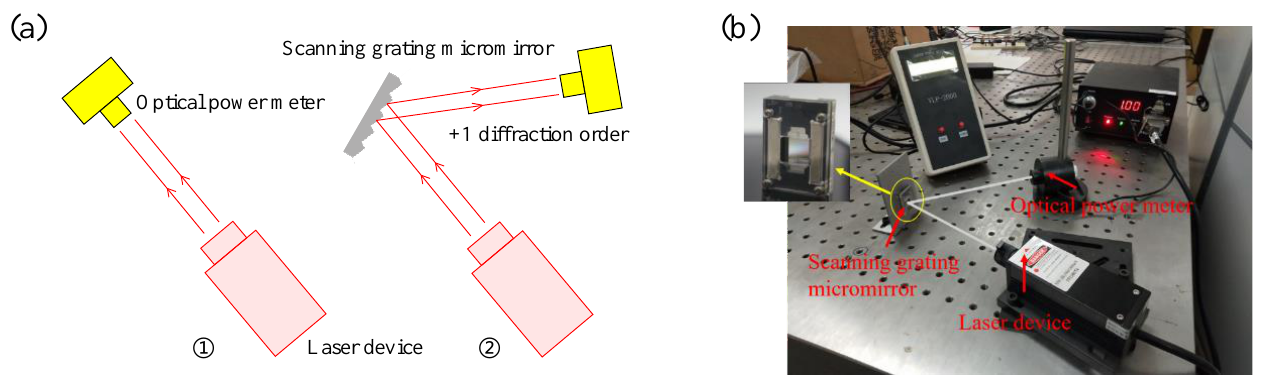
Figure 14. ( a ) Schematic diagram and ( b ) photography of the grating diffraction efficiency measurement setup.